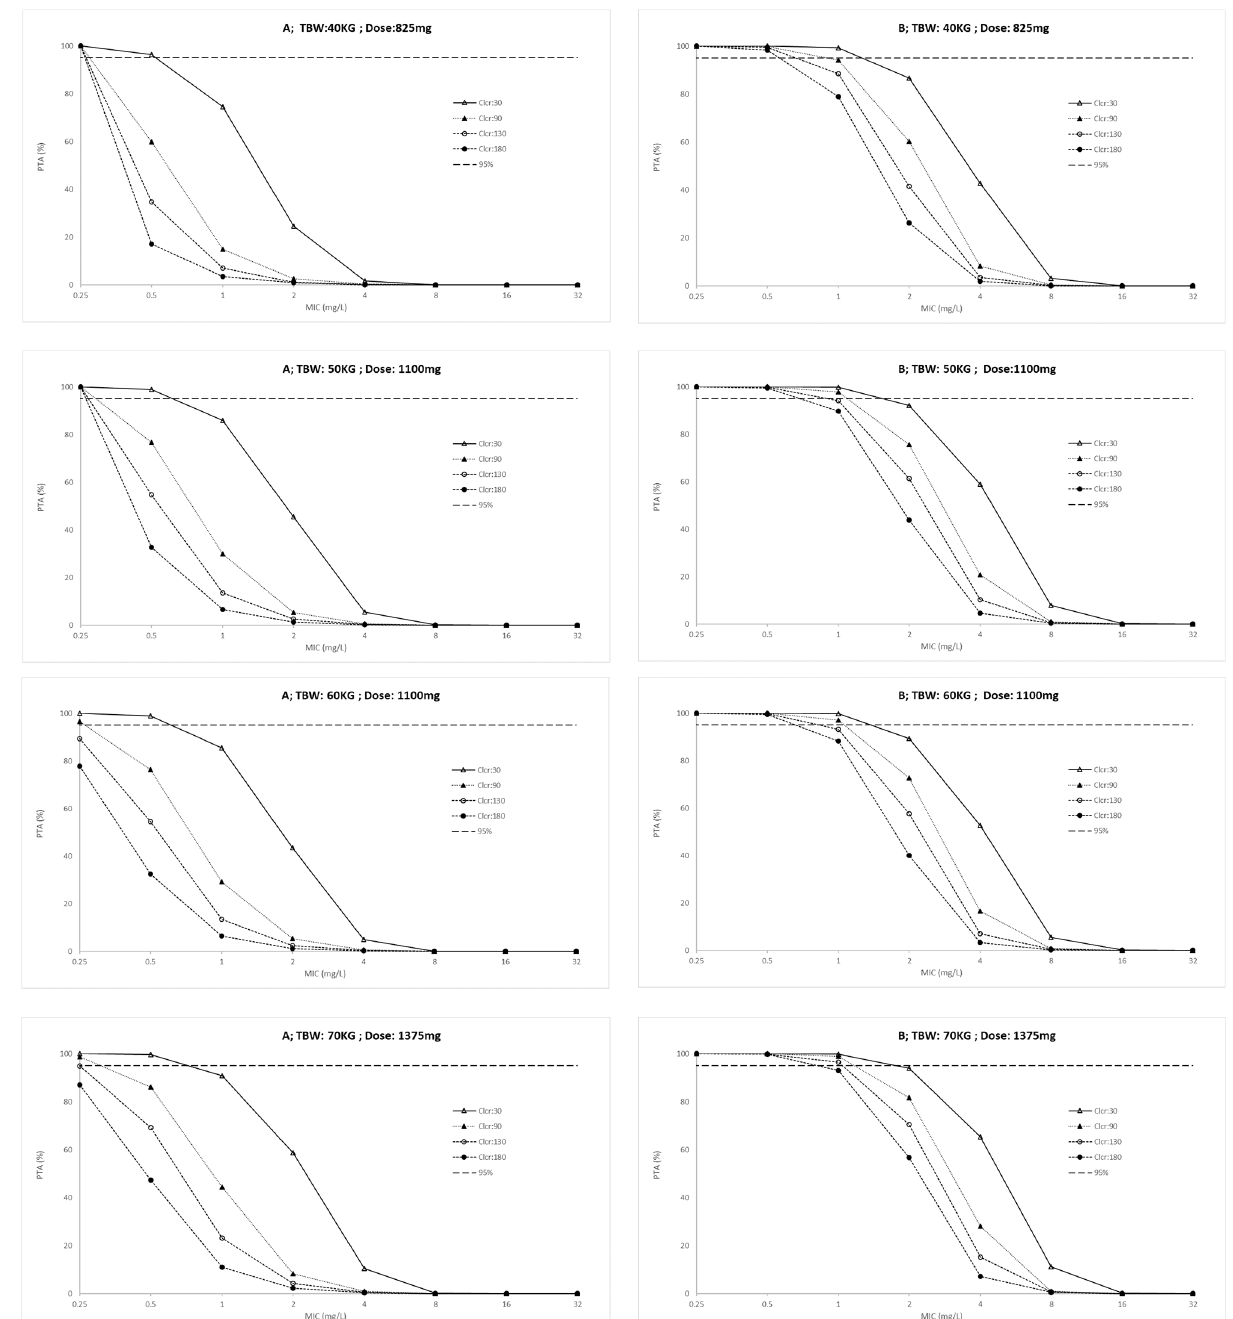
Figure 2. Probability of target attainment ( A : AUC (0–24) /MIC > 11.9 and B : C max /MIC > 0.48) in ICU patients for conventional ethambutol dosing regimen according to total body weight (TBW, 40 to 70 Kg) and creatinine clearance (Clcr, 30 to 180 mL/min). PK/PD targets higher than 95% were considered desirable.